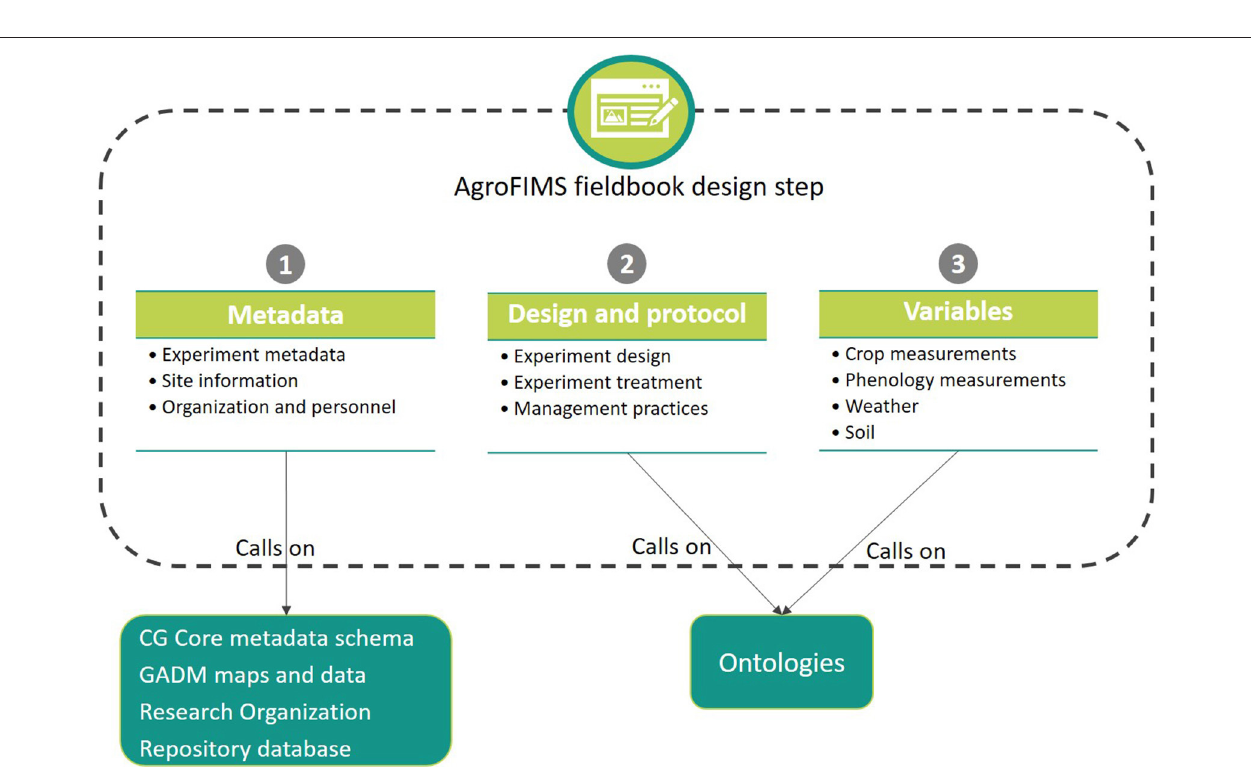
FIGURE 2 | Main modules and their subcomponents of AgroFIMS ‘’fieldbook design”